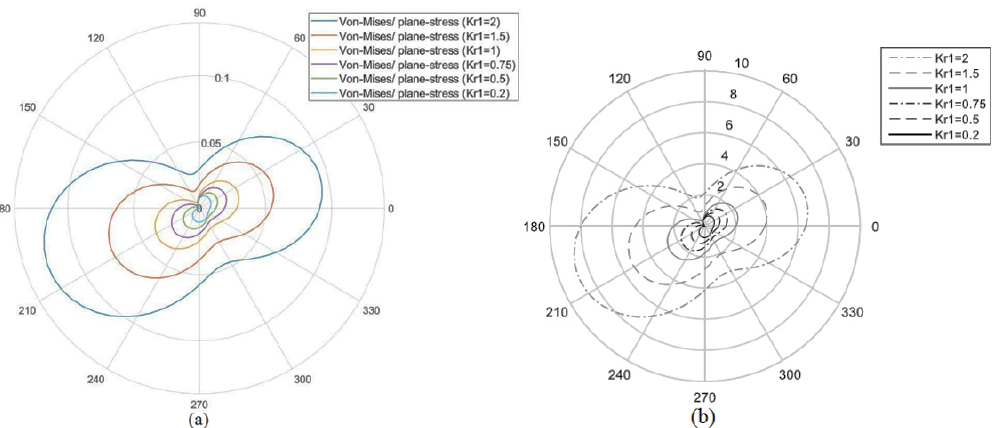
Figure 4. The shapes of the plastic zone around a sharp crack based on the von Mises yield criterion. ( a ) Results derived from the present study; ( b ) reported in [63].